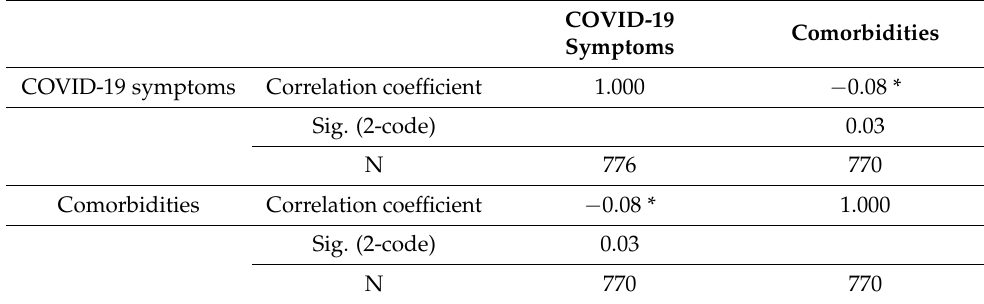
Table 3. Correlation between COVID-19 symptoms and comorbidities.